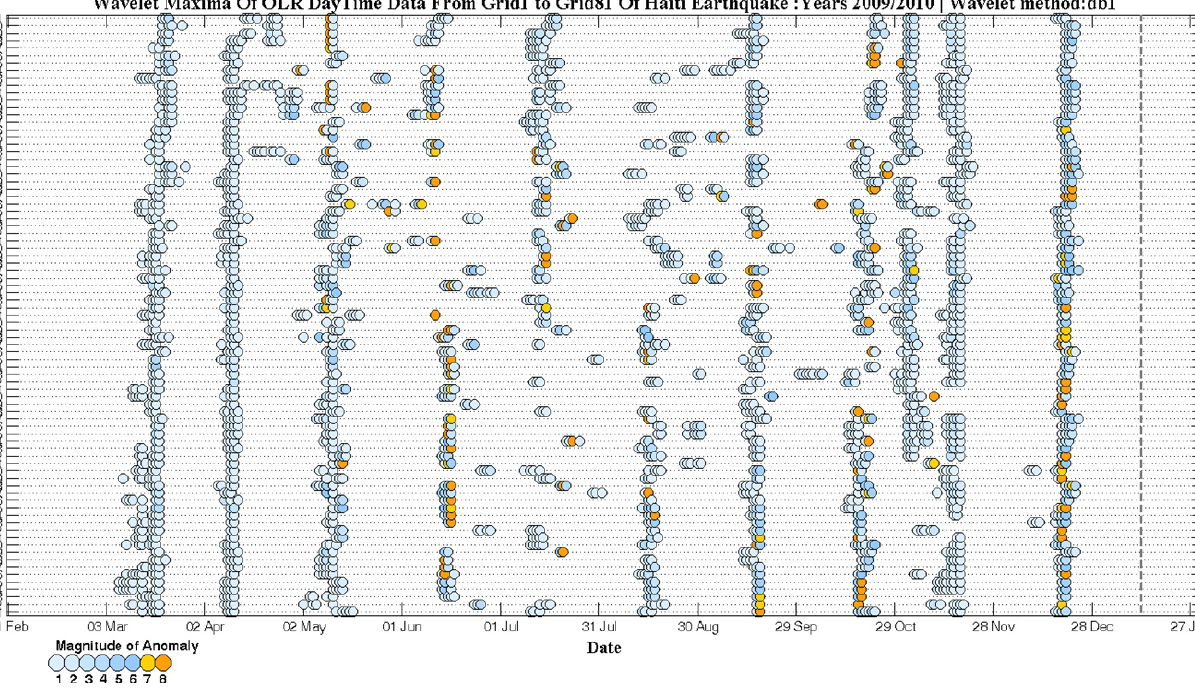
Fig. 7. Wavelet maxima analysis curves from Grid1 to Grid81, with a set of grids of 9 × 9degree of latitude by longitude area over the epicenter, the dashed line indicates the day when the earthquake